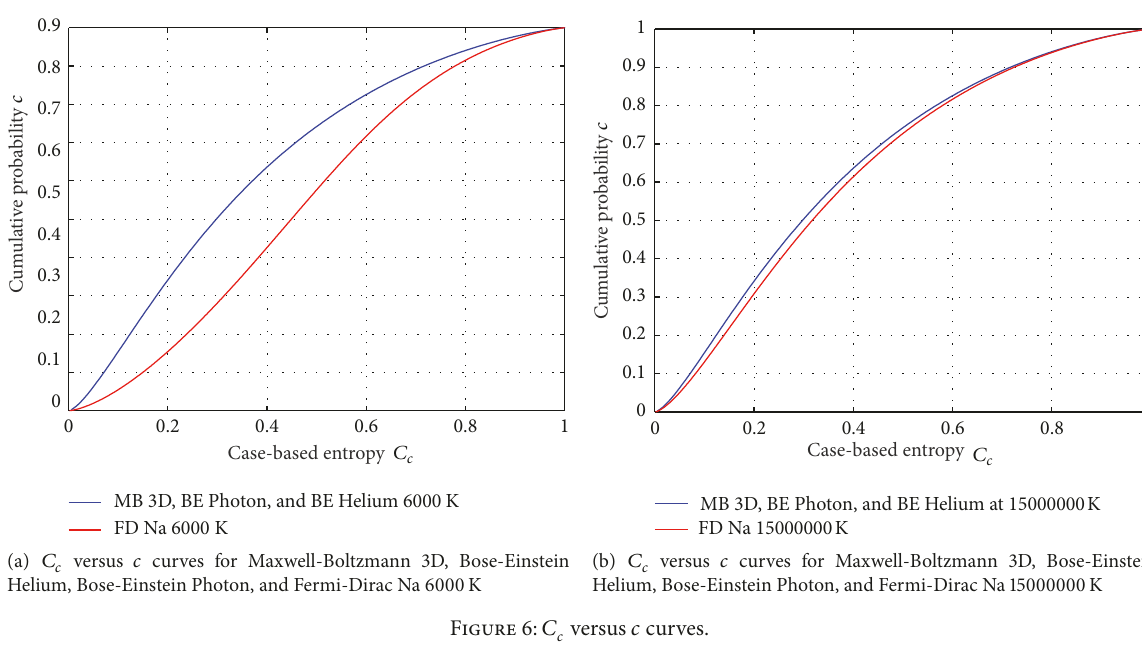
(b) Energy density curves for Maxwell-Boltzmann 3D, Bose-Einstein Helium, Bose-Einstein Photon, and Fermi-Dirac Na 15000000K Figure 5: Energy density curves.